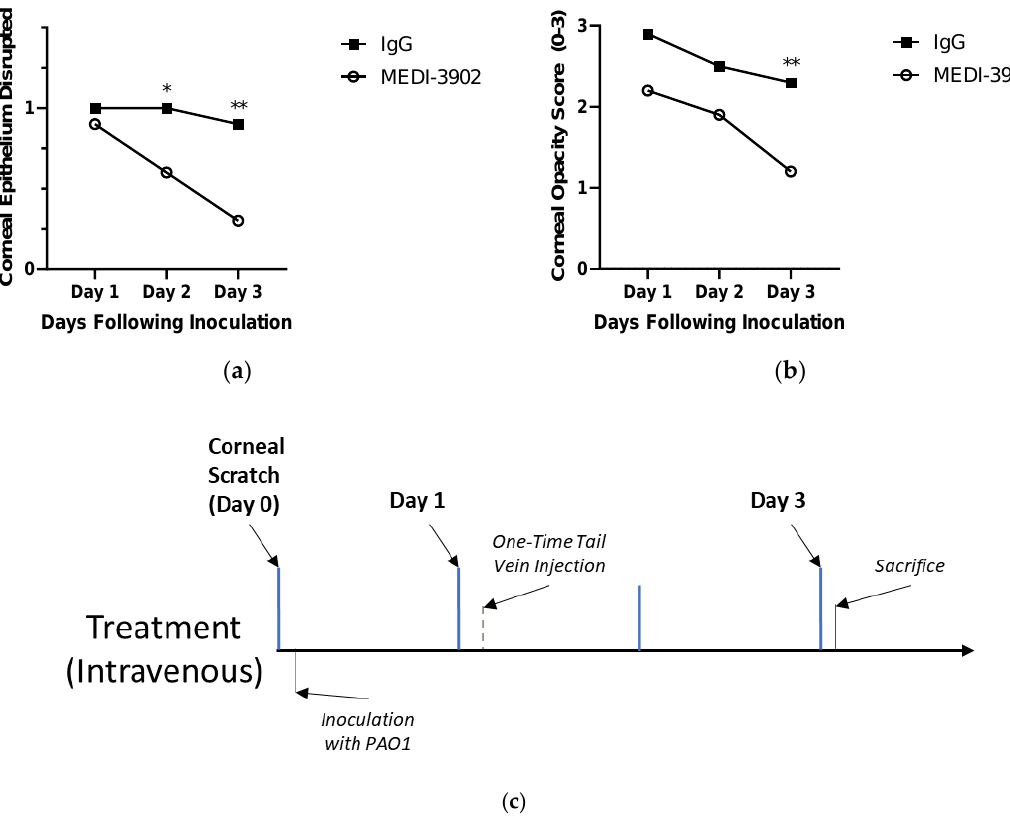
Figure 4. MEDI3902 can treat PAO1 keratitis when given as a one-time, intravenous injection through the tail vein of mice: Mice with active Pseudomonas keratitis treated with a one-time, intravenous injection of MEDI3902 ( n = 10) saw a decrease in the number of mice with disrupted epithelia ( a ) and a decrease in the overall corneal opacity ( b ) throughout three days observation following treatment compared to the the IgG treated mice ( n = 10). (Mean ± SEM) Opacity scores: MEDI3902 treated Day 1 = 2.2 ±